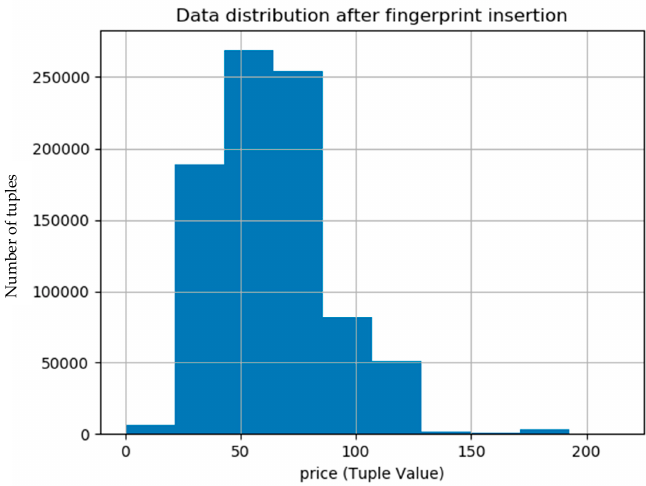
Figure 10. Histogram showing the distribution of fingerprinted